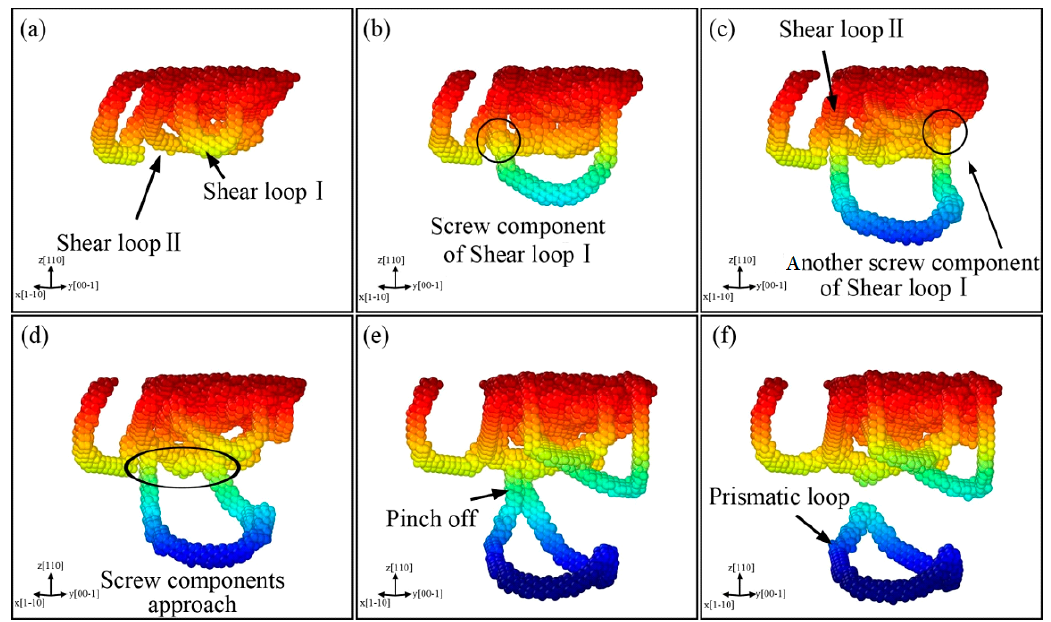
Figure 12. Formation of prismatic loops based on extended “lasso”-like mechanism for indentation on (110) plane, with colors representing depth from sample surface. The evolution process is illustrated on each subfigure from ( a – f ).